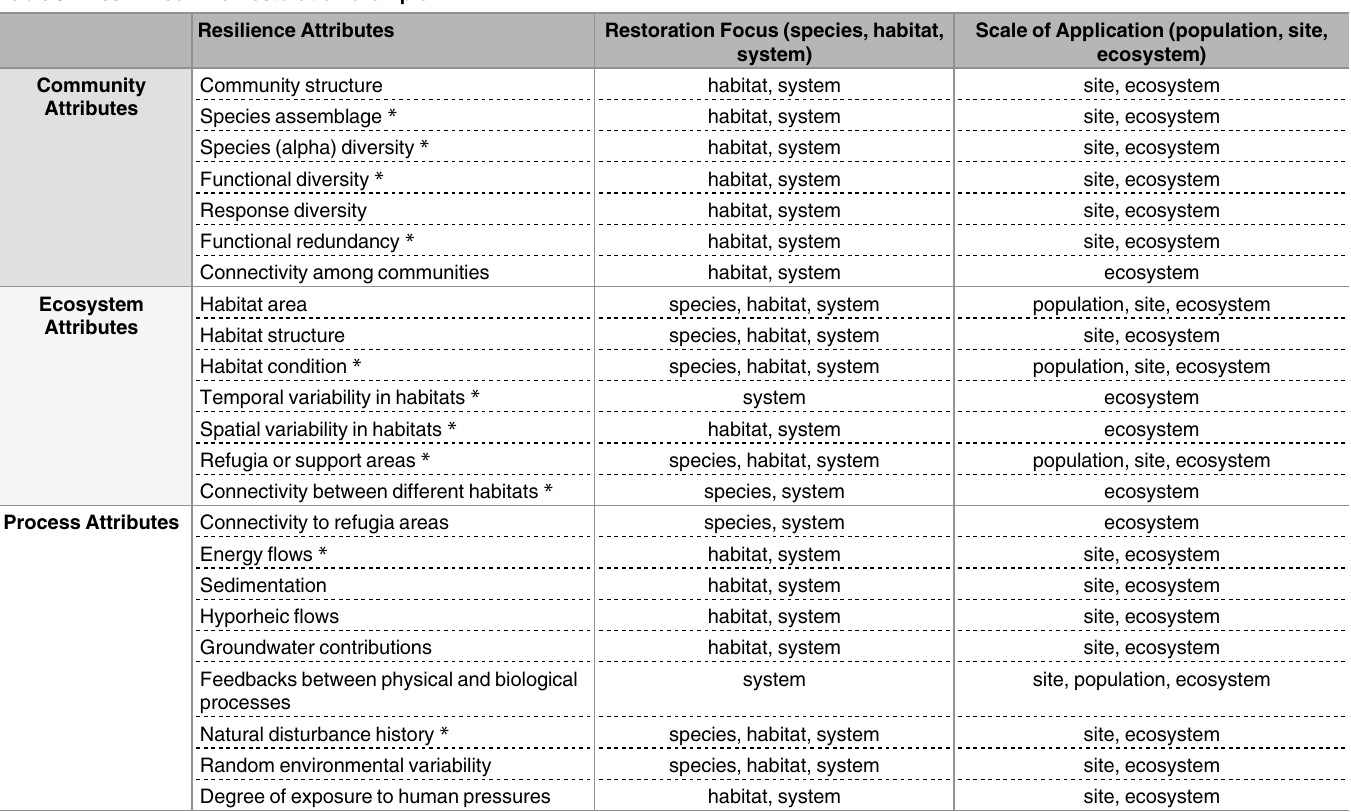
Table 3. KissimmeeRiver restoration